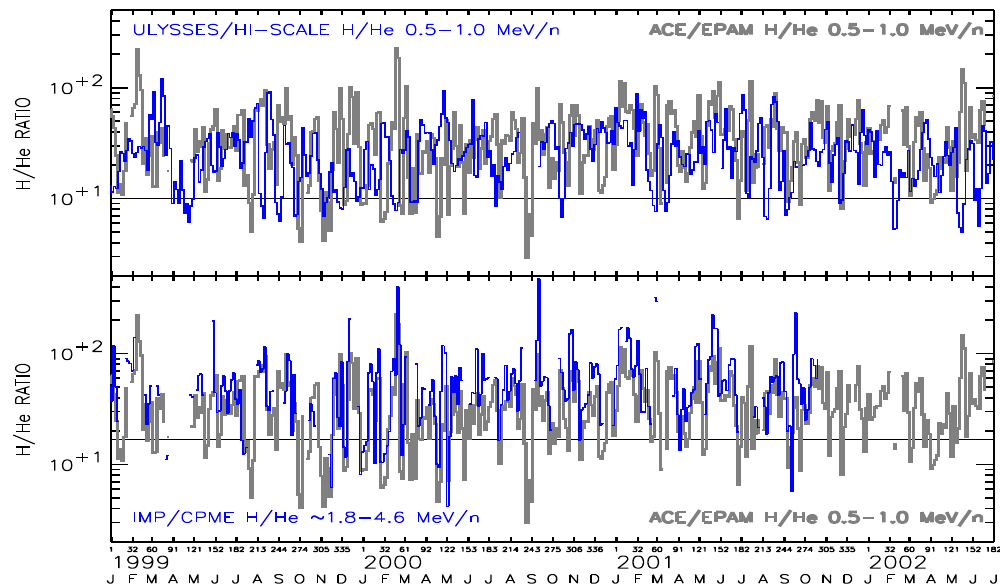
Fig. 7. Overplot of the H/He ratios shown in panel (C) of Fig. 6 (gray traces) and the H/He ratios shown in panels (C) of the bottom graphs in Figs. 1 and 3 (black